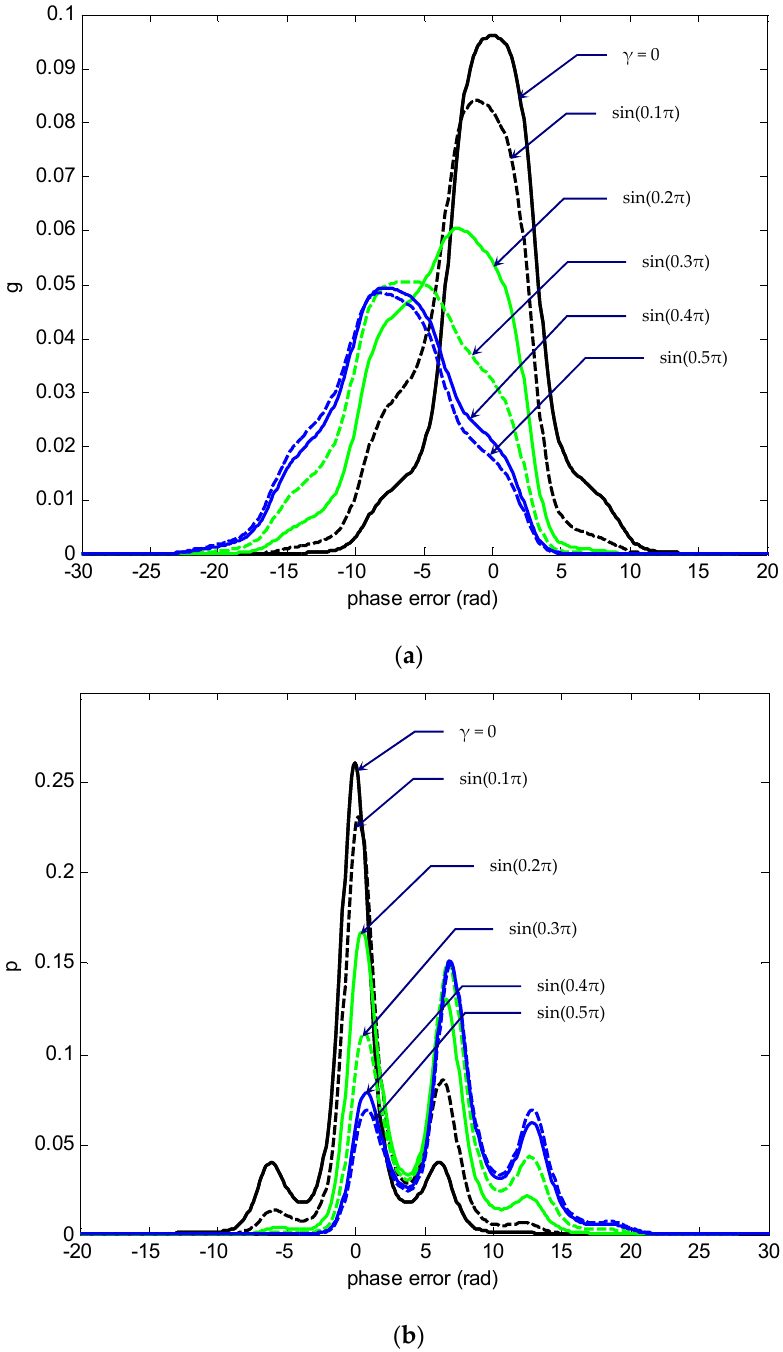
Figure 14. Nonmodulo-2 π phase-error ( a ) density function g ( φ , τ ) and ( b ) PDF p ( φ , τ ) , at τ = 10 for various detuning factor γ when SNR α = 1 .